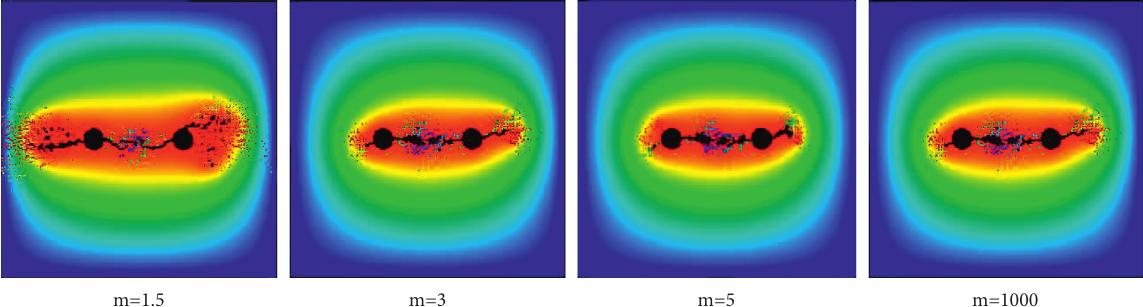
Figure 6: Morphology of hydraulic fractures with different homogeneity index ( K � 1, L � 130mm).